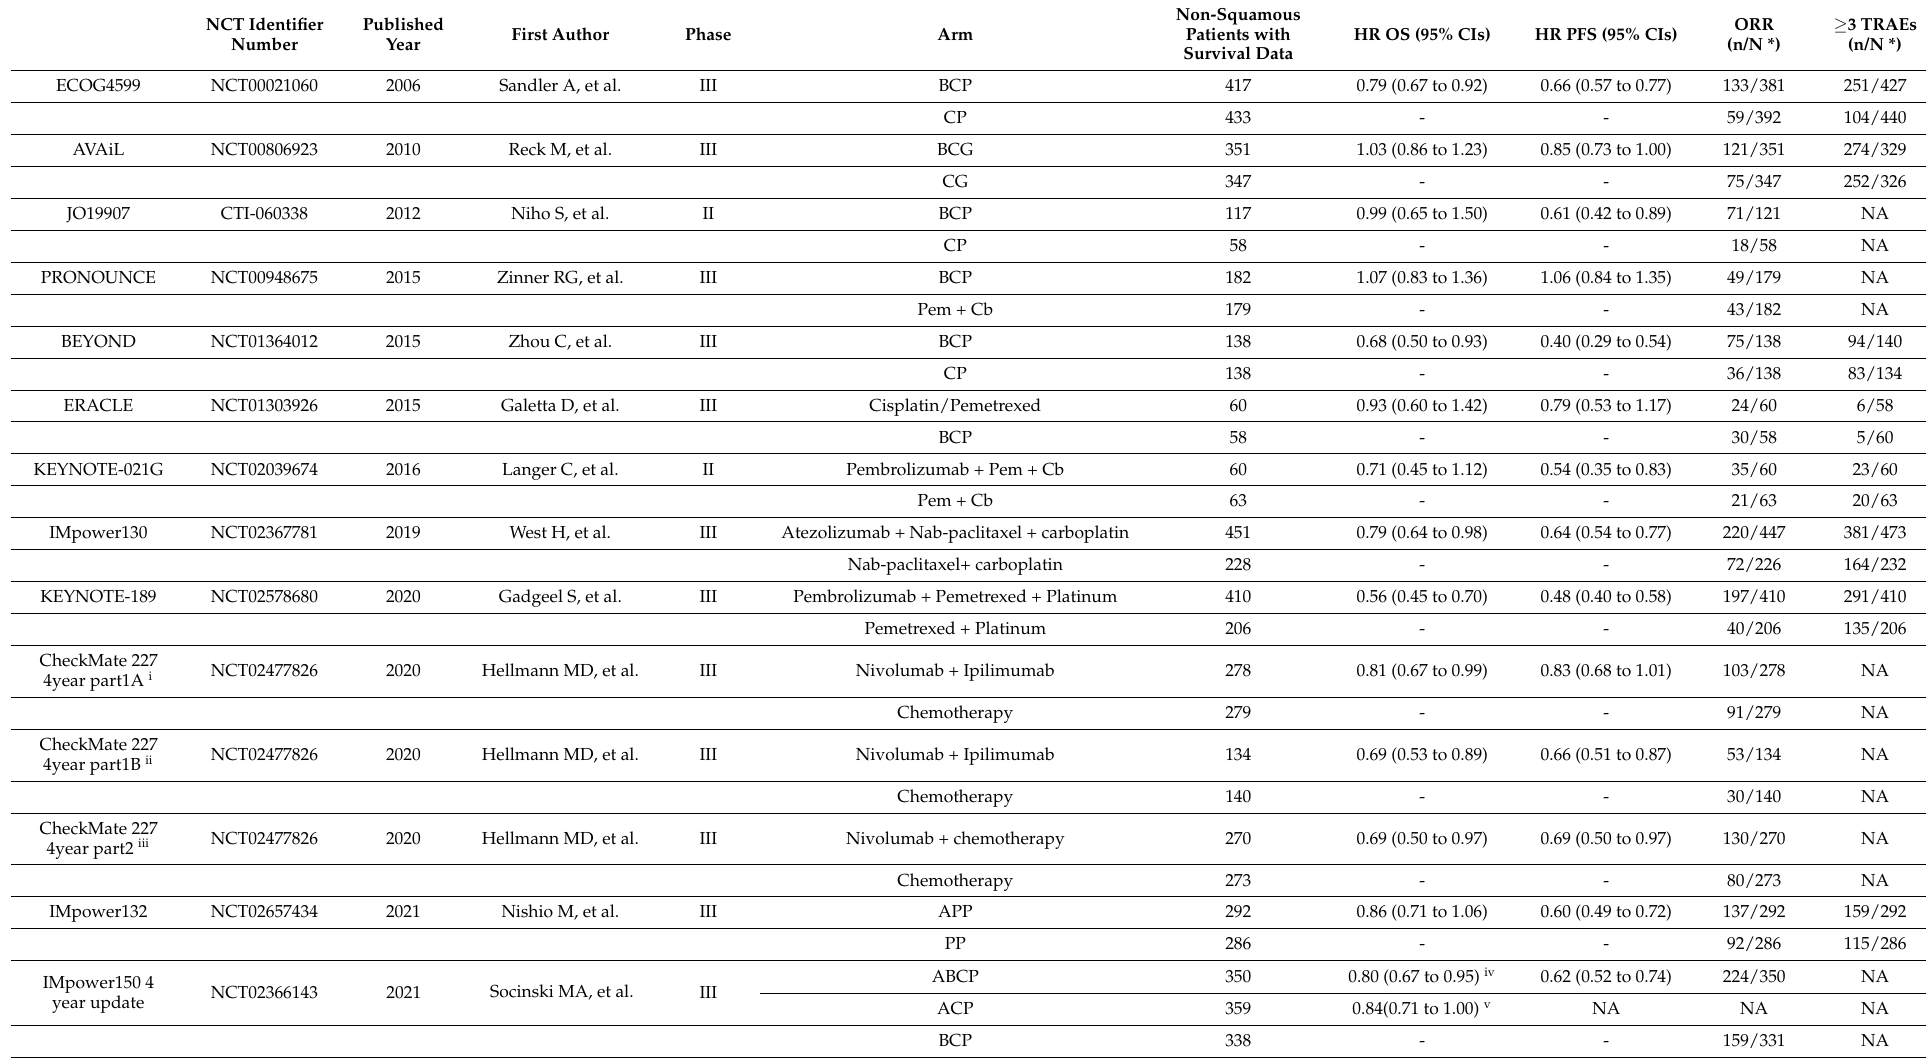
Table 1. Baseline Characteristics of the included randomized controlled